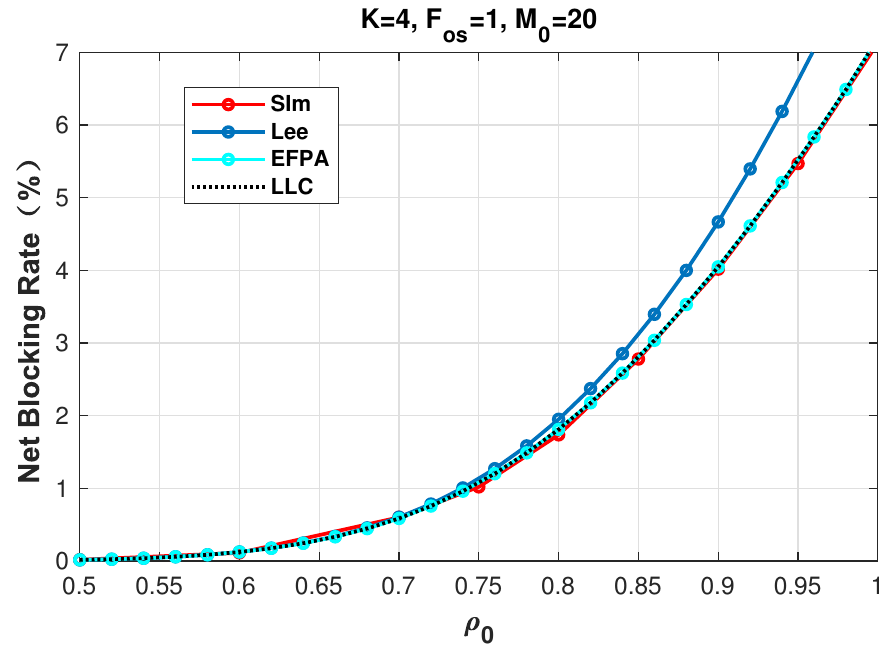
Figure 3. Network blocking performance of different methods with K = 4, F OS = 1, and M 0 =